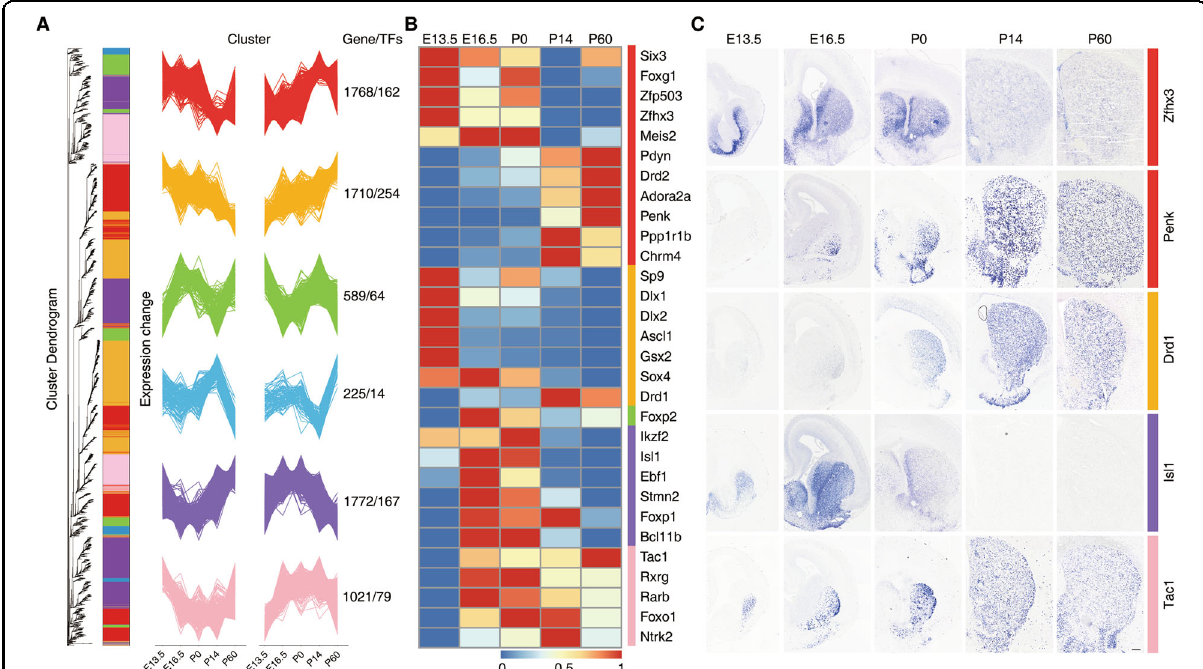
Fig. 3 Co-expression analysis of differentially expressed continuous genes. A Hierarchical clustering dendrogram based on the dynamic hybrid tree cut algorithm shows co-expression modules of continuous genes that are color coded. The co-expressed genes are rearranged, and fuzzy c-means clustering identi fi es two distinct temporal patterns of each co-expression module. The x-axis represents fi ve developmental points, while the y-axis represents log2-transformed, normalized intensity ratios. The number of genes and TFs in each module is shown on the right. B Expression pattern of reported striatal development genes at fi ve time points. C The expression patterns of striatal development genes were veri fi ed by in situ hybridization at fi ve time points. Scale bars: 100 μ m in